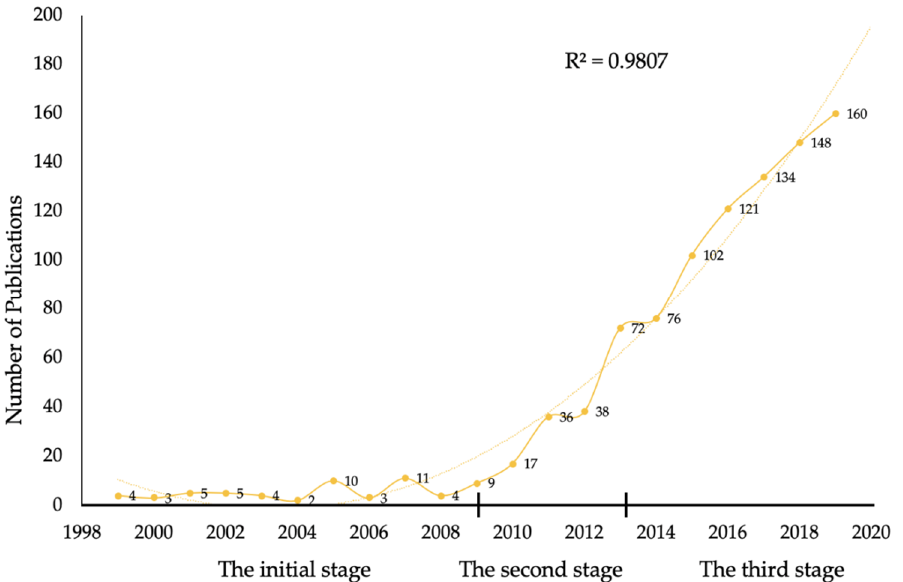
Figure 2. The output of publications and growth prediction of CTE research. The number of publications from 1999 to 2019 are represented by the solid line; the dashed line represents the predicted curve, R 2 = 0.9807.